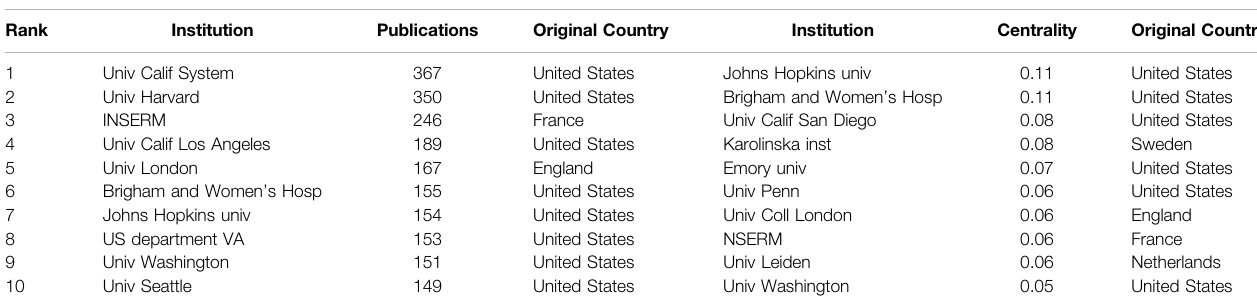
TABLE 2 | Top 10 institutions distributed by publications and